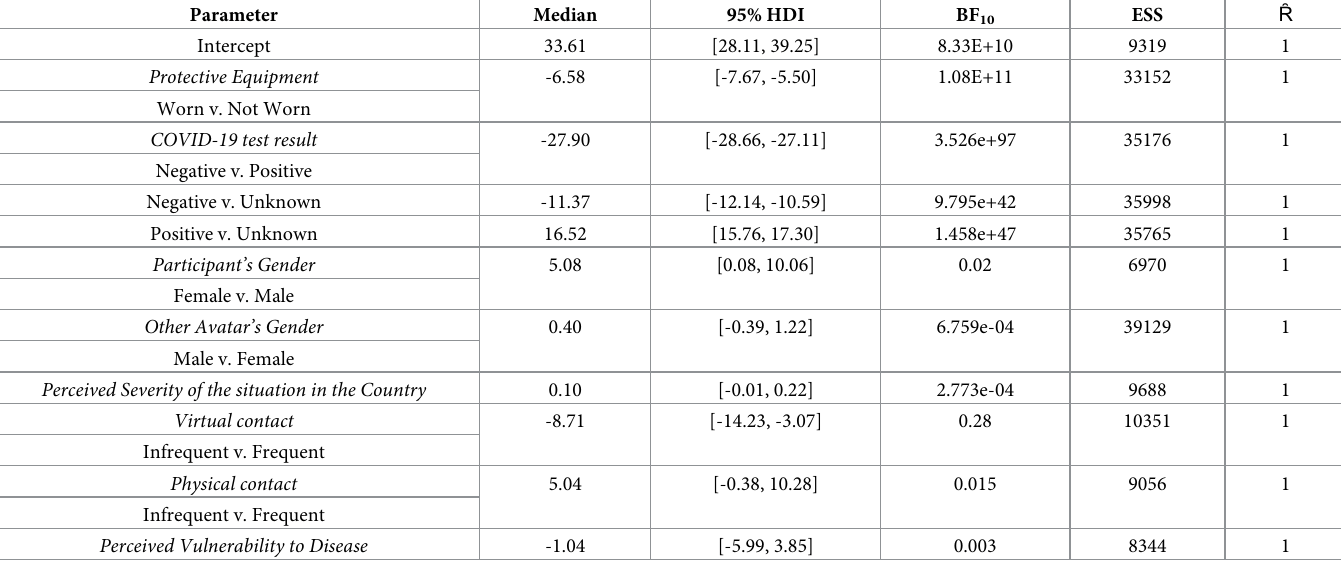
Fig 2. Probability of direction and the magnitude of the effect for each predictor included in the study. The y-axis indicates the predictors and the x-axis indicates the possible parameter values. The color indicates the direction of the effect: black stands for a negative direction (reduction of IPD), while gray represents a positive direction (enlargement of IPD). The effect of the parameters included in the final model whose HDI are completely outside of zero are marked with “-” (if the direction of the effect is negative) or a “+” (if the direction of the effect is positive). The interaction between COVID-19 Test Result and Protective Equipment and the interaction between Participant’s Gender and Other Avatar’s Gender are better explained by the contrasts between all levels of the factors (COVID-19 Test Result: Protective Equipment see Table 4 and Fig 3; Participant’s Gender: Other Avatar’s Gender see Table 5). https://doi.org/10.1371/journal.pone.0255598.g002 strong evidence that providing information regarding a positive COVID-19 test result increased IPD. In particular, we found a continuous increase in the space that participants put Table 4. Summary of the final